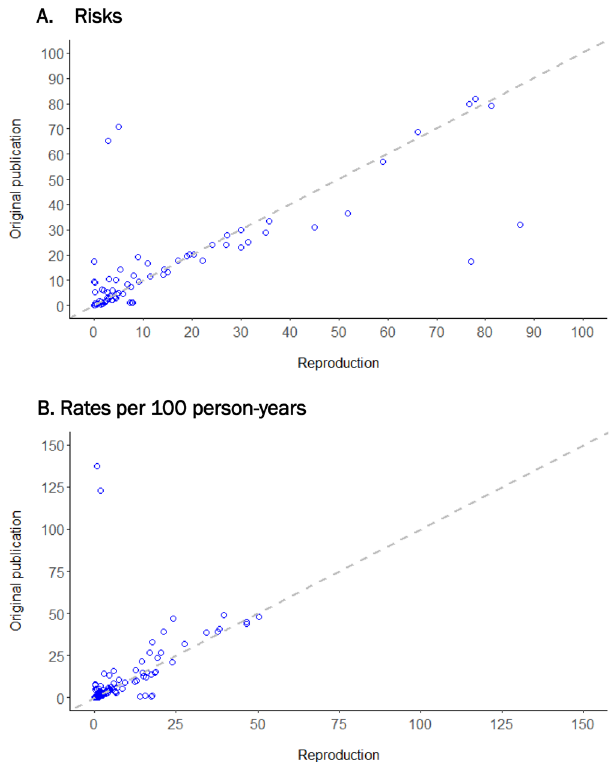
Fig.3|Calibrationinrisksorratesofoutcomebetweentheoriginalpublication versusthereproduction(original – reproduction).A RisksDasheddiagonalgray line re fl ects equal outcome risk identi fi ed in original and reproduction cohorts. B RatesDasheddiagonalgraylinere fl ectsequaloutcomeratesidenti fi edinoriginal and reproduction cohorts. Source data are provided as a Source Data fi